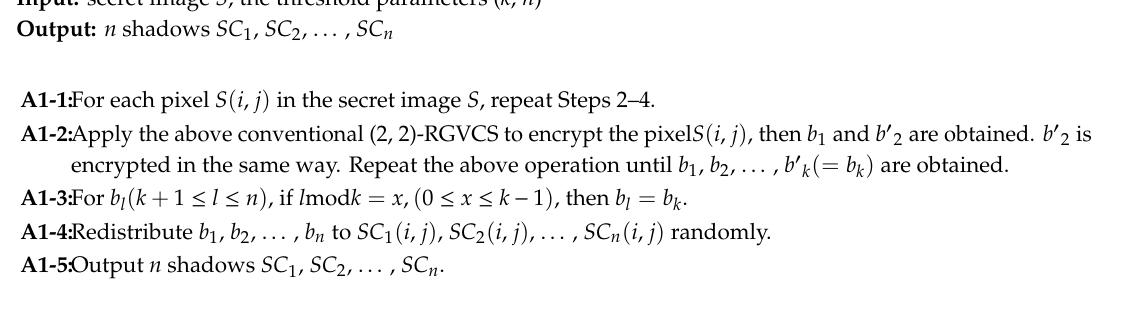
Algorithm 1. Yan et al.’s RGVCS.